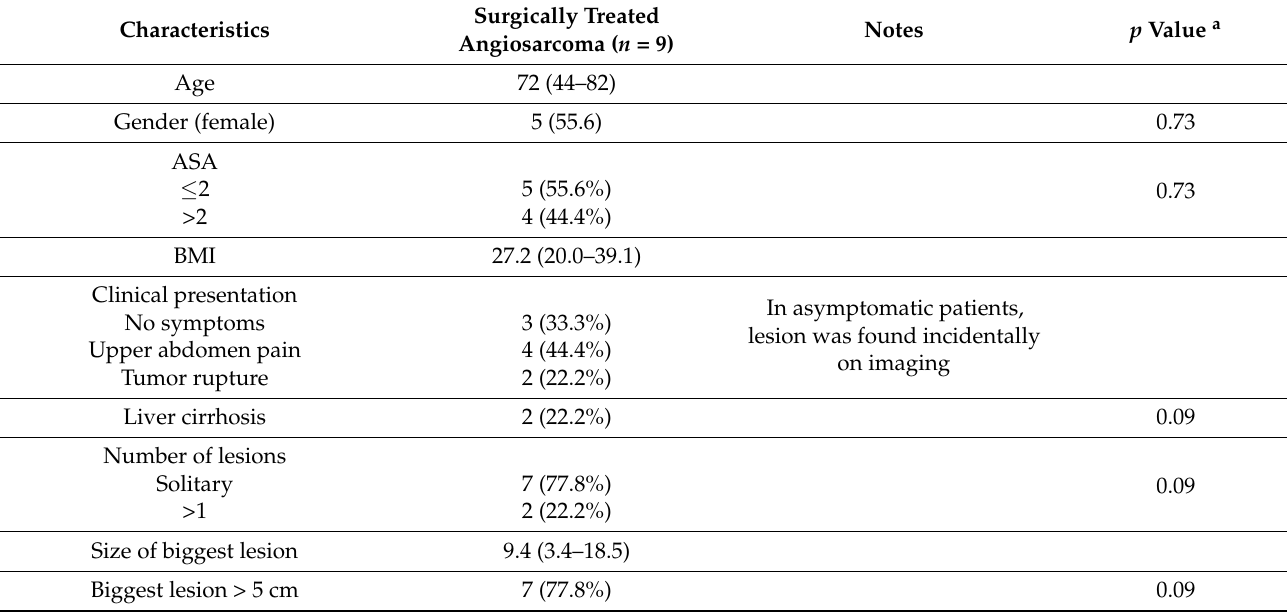
Table 1. Demographic data of